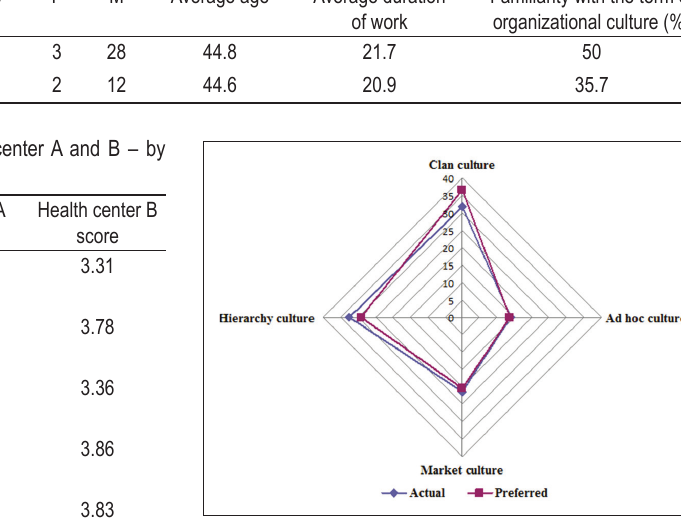
FIGURE 1. The actual and preferred organizational culture in PHC center A (p>0.05)